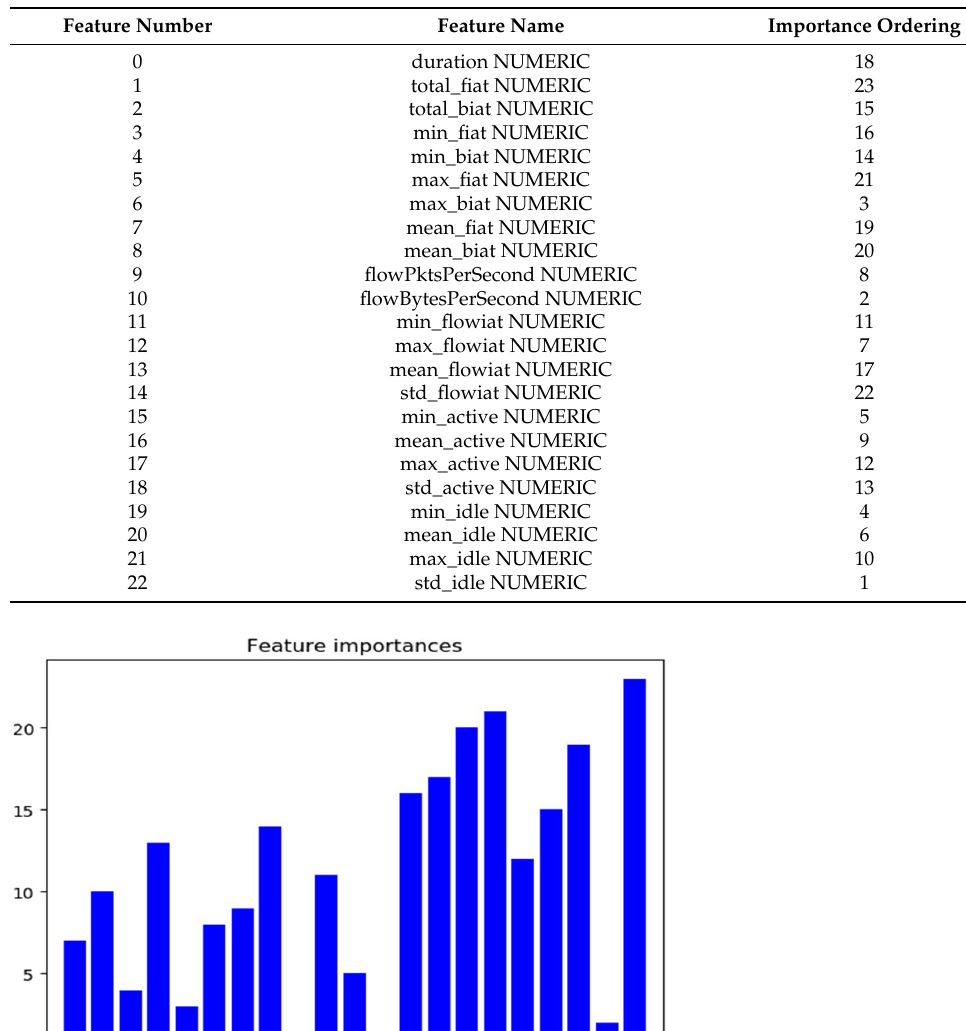
Figure 6. Encrypted traffic capture path. Table 3. The importance of data features.